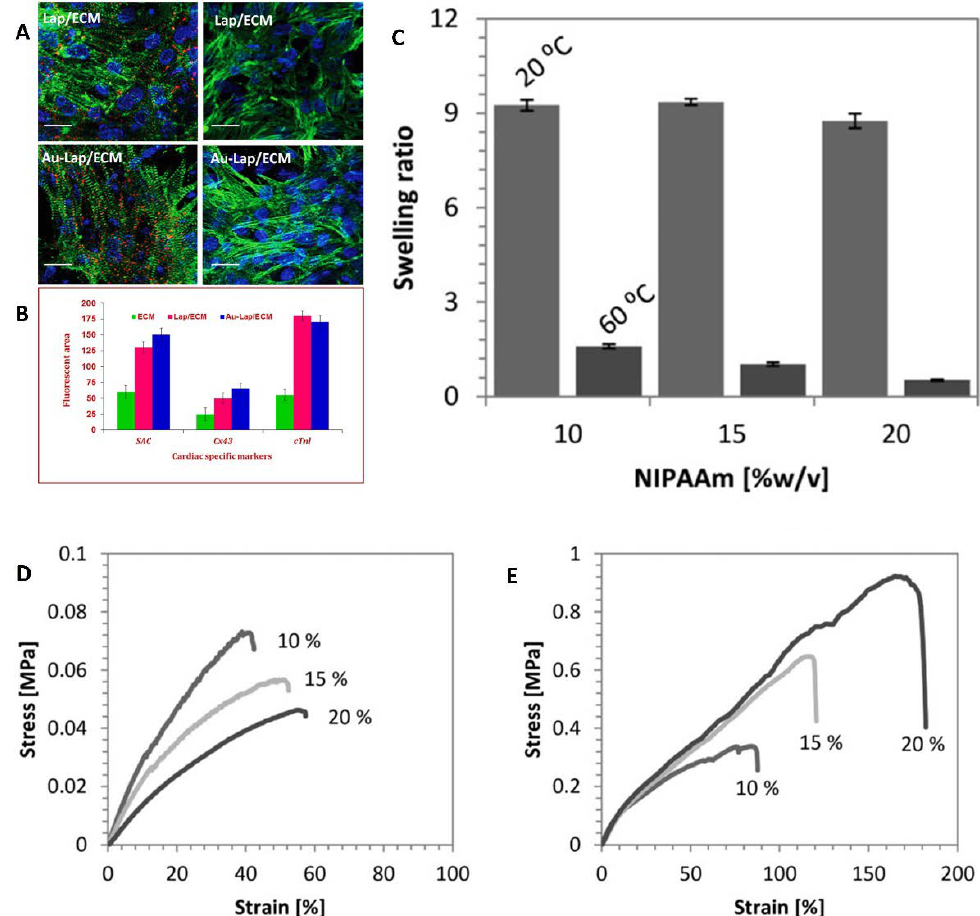
Figure 3. ( A ) Cytoskeleton arrangement of cardiomyocytes under cardiac-specific markers. ( B ) Bar graph of covered area representing immunofluorescence images of cardiomyocytes (adapted from [78] ). ( C ) Swelling ratios of alginate/PNIPAAm ICE hydrogels with varying concentrations (10%, 15%, and 20% ( w / v )) of N-isopropylacrylamide concentrations at 20 and 60 °C. ( D ) Tensile stressstrain curves of alginate/PNIPAAm ICE hydrogels at 20 °C. ( E ) Tensile stress–strain curves of alginate/PNIPAAm ICE hydrogels at 60 °C (adapted from [79] ).